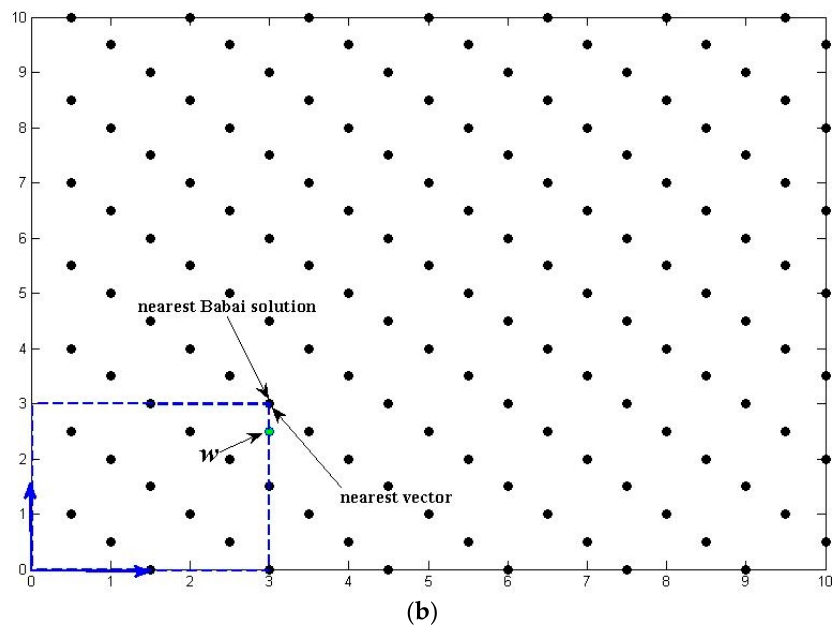
Figure 1. Illustration of “Bad” and “Good” lattice basis.